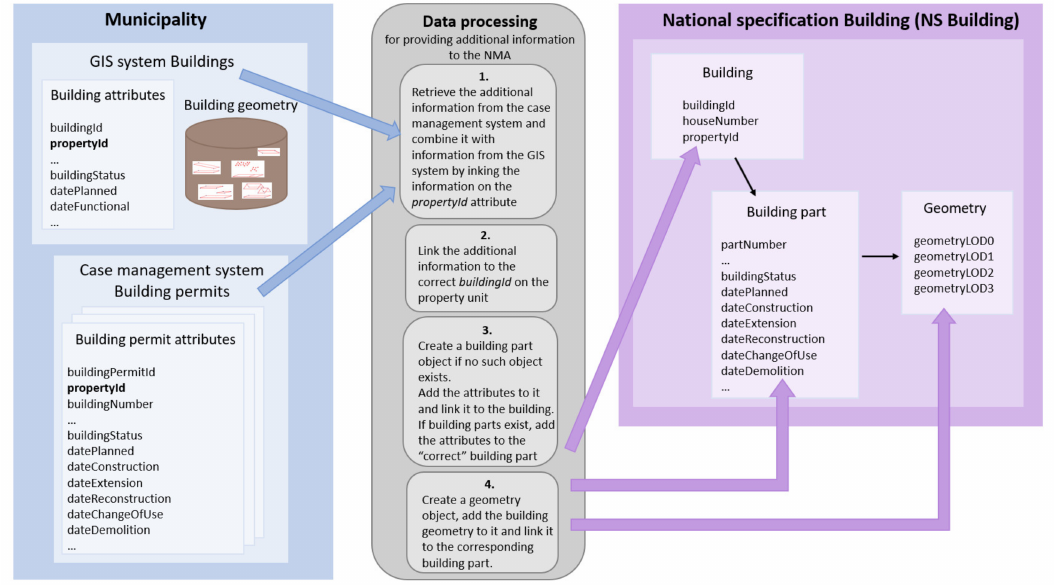
Figure 4. Simplified description of how temporal and versioning data from the municipality must be processed to conform to national specification (NS)